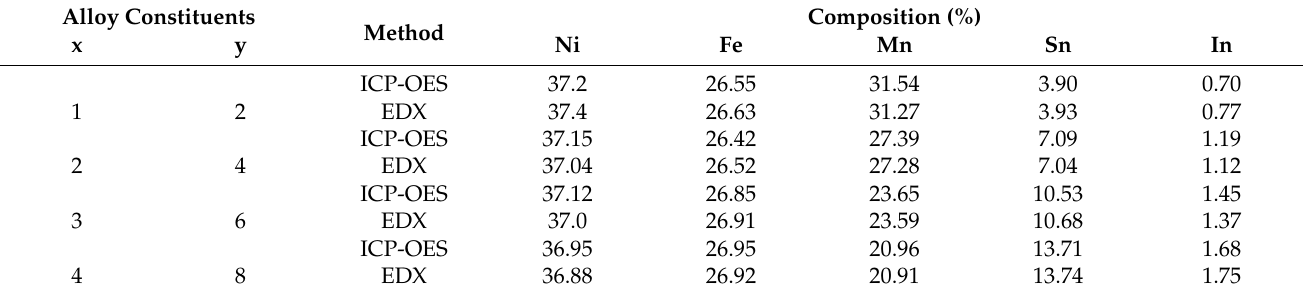
Table 1. Composition analysis of arc melted alloy using the ICP-OES and EDX